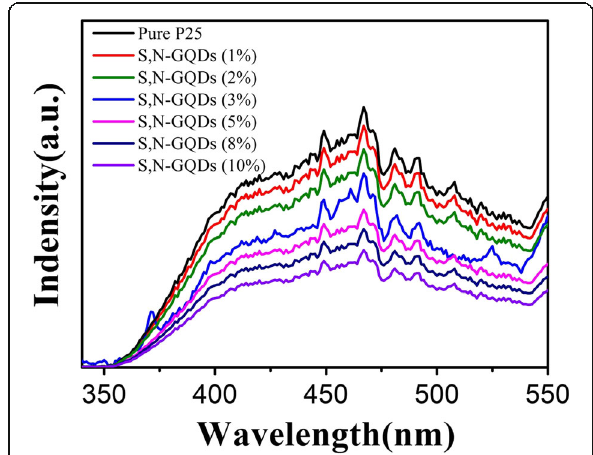
Fig. 10 PL spectra of pure P25 and and S,N-GQD/P25 composites with different amounts of S,N-GQDs. Excitation wavelength: 280 nm